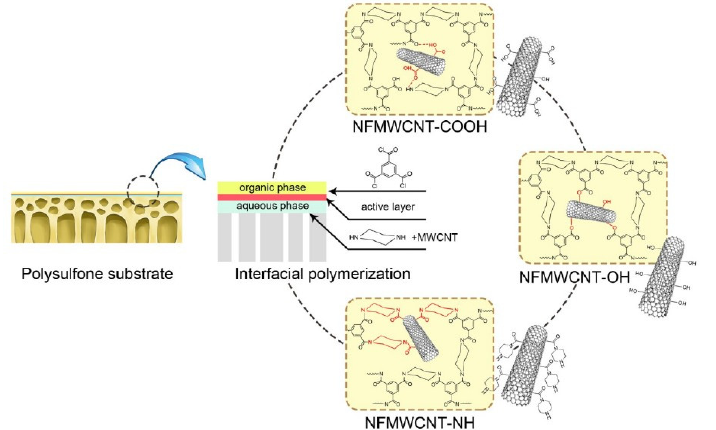
Figure 11. Schematic illustration for the preparation of different nanocomposite NF membranes via interfacial polymerization [106]. Reprinted with permission from { Xue, S.M.; Xu, Z.L.; Tang, Y.J.; Ji,